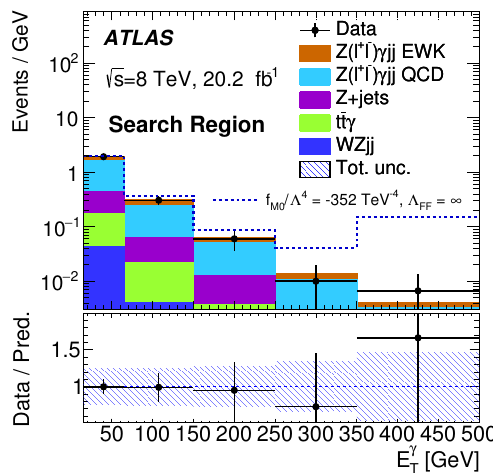
Figure 8 . Distributions of the photon transverse energy for the electron and muon channels added together in the search region, for the data (black points), and for the signal process and various background components (coloured templates) before any (cid:12)t is done. The sum of the signal prediction with one non-zero aQGC parameter and the various backgrounds discussed in the text is also shown (blue dashed line). The ratio between data and the sum of all pre-(cid:12)t expected contributions (\Pred.") is shown below the histogram. The hatched blue band shows the systematic and statistical uncertainty added in quadrature (\Tot. unc.") in the signal and background prediction, while the error bars on the data points represent the statistical uncertainty of the data set. The number of events in each bin is divided by the bin width. The last bin also includes events beyond the range shown.